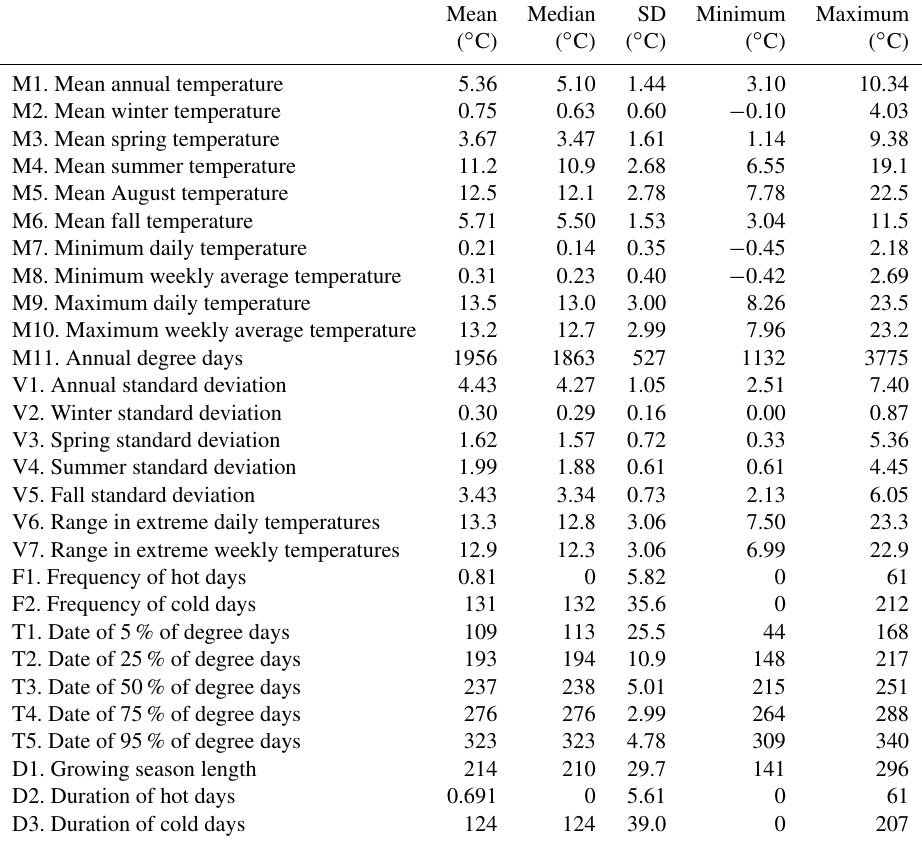
Table 3. Descriptive statistics for temperature metrics used to describe thermal regimes at 226 monitoring sites in mountain river networks. Statistics were calculated from the imputed time series and mean daily values for the period